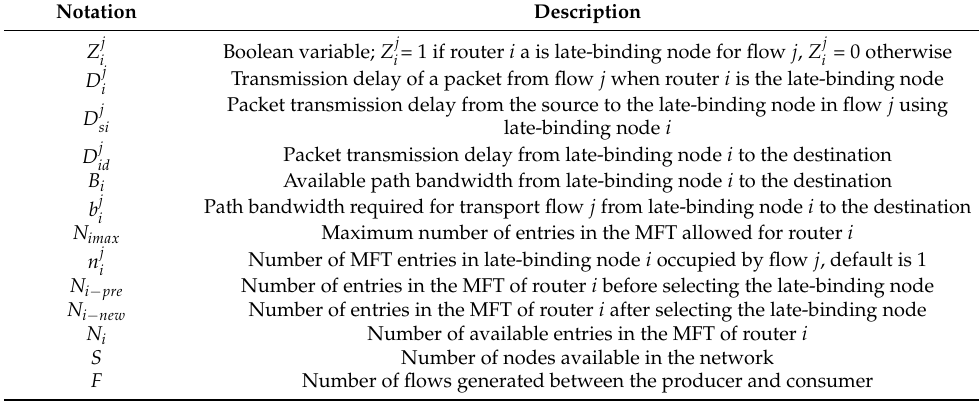
Table 1. Summary of notations.